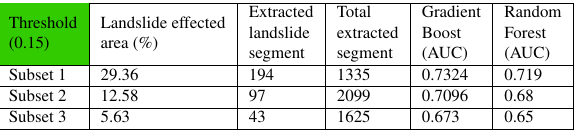
Table 4: Result for subset(Test area)